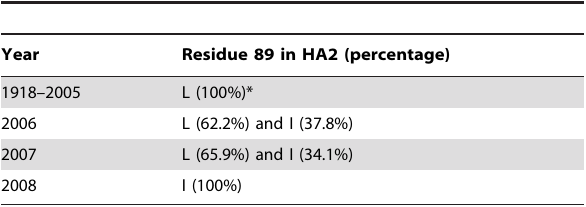
Table 4. Evolutionary changes of residue 89 in human H1N1